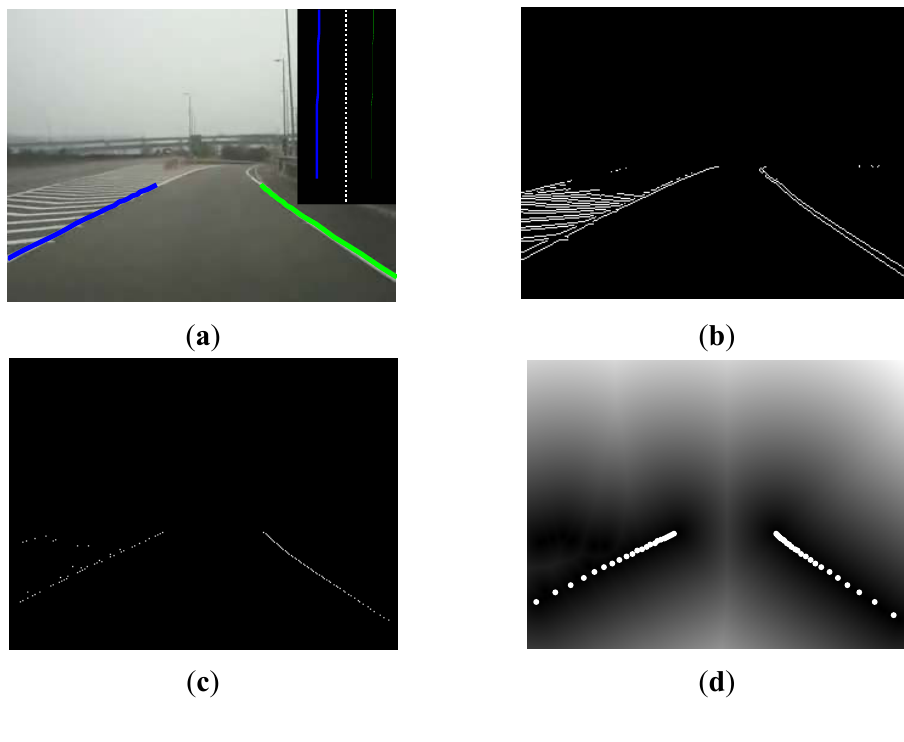
Figure 4. Image measurement examples of lane particle, ( a ) input image, ( b ) edge image, ( c ) lane marking characteristic point image, and ( d ) distance transformation image and lane model coordinate point